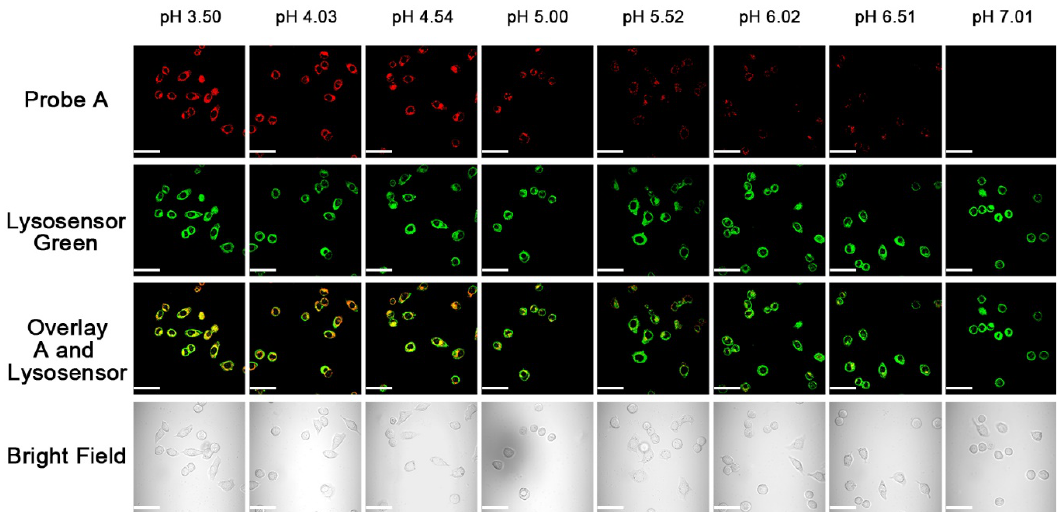
Figure 12. Confocal fluorescence images of HeLa cells incubated with probe A and Lysosensor Green in different pH buffers containing 10 µM nigericine with scale bars at 50 µm. The excitation of Lysosensor green is 405 nm and the fluorescence collect window is from 500 to 550 nm.